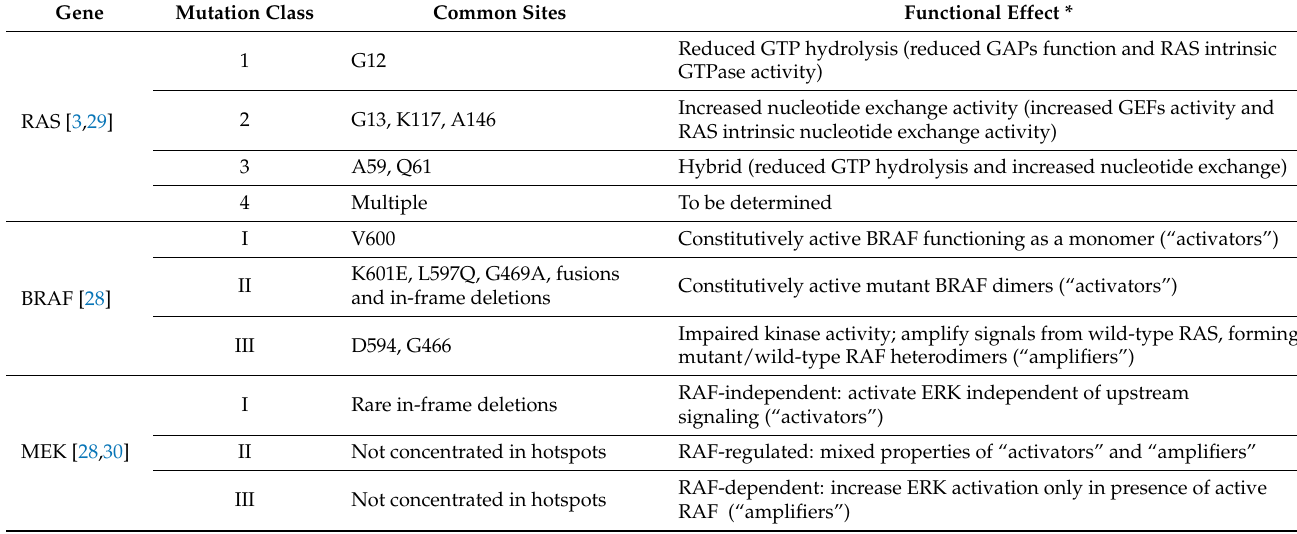
Table 1. Classes of mutations affecting RAS, BRAF, and